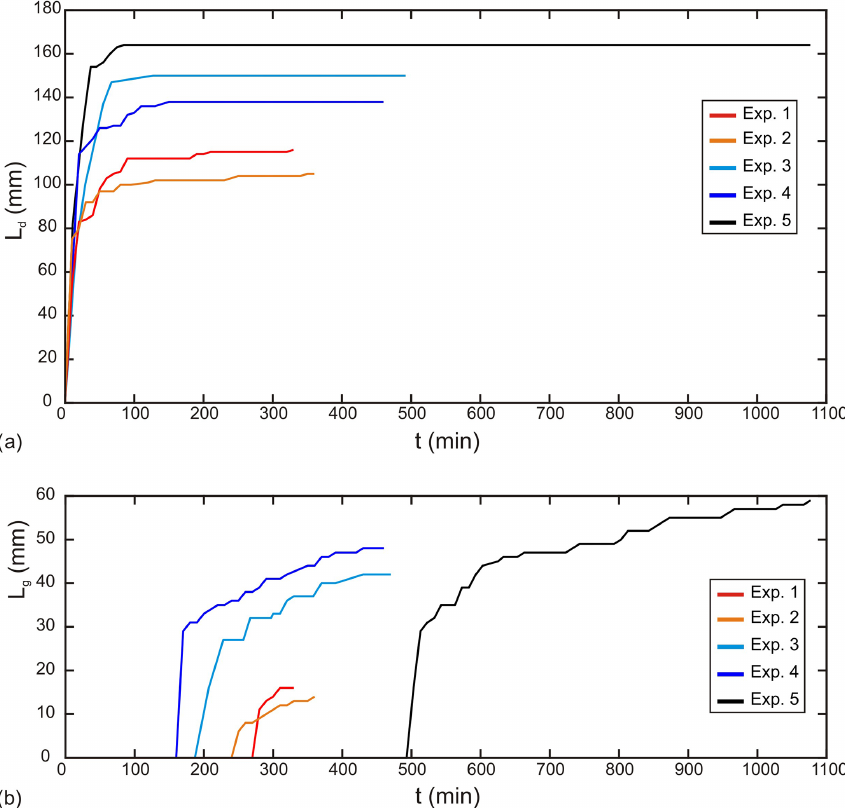
Figure 9. (a) Time evolution of the dome diameter ( L d ). (b) Time evolution of the apical depression width ( L g ). Both L d and L g show a similar evolution trend with a first stage of abrupt increase at the beginning of each experiment. In the second stage L d becomes constant at t ∼ 90min (experiments 1–2–3), t ∼ 150min (experiment 4) and t ∼ 65min (experiment 5), while L g increases slightly from t ∼ 250– 280min (experiments 1–2), t ∼ 210 and ∼ 170min (experiments 3 and 4), and t ∼ 530min (experiment 5) until the end of the